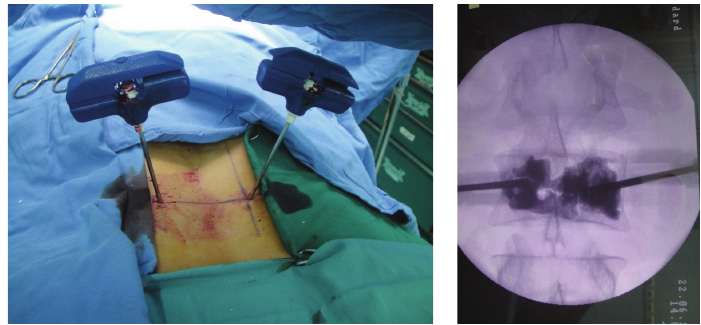
Figure 2: Bipedicular approach in VP. Note the relatively homogenous distribution of the cement through the VB.